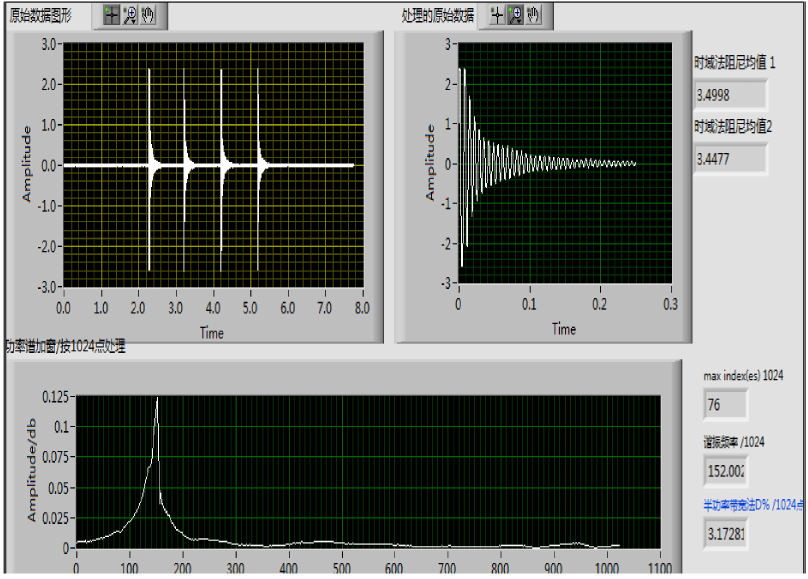
Figure 5. Acceleration response signals as